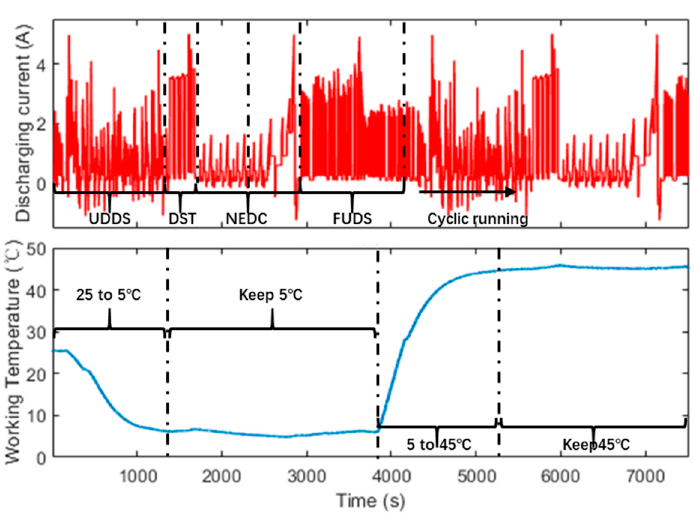
Figure 8. Combined variable temperature and operating condition.